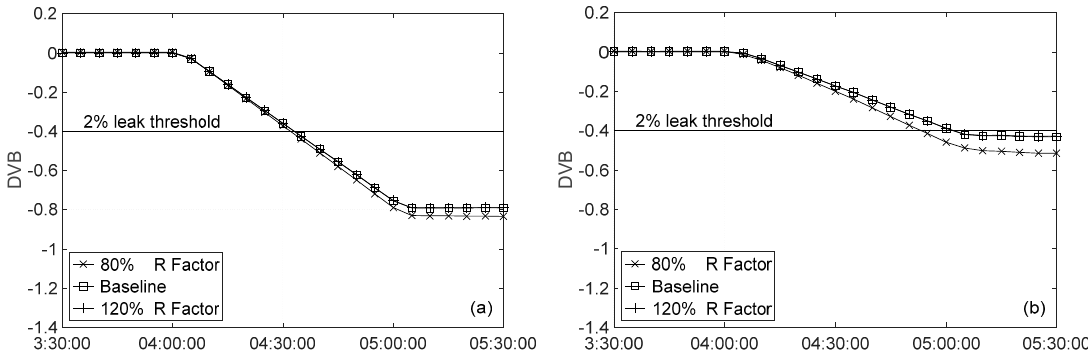
Figure 3. Effect of viscosity error on leak detectability in a system with R = 2.20 with 1% Gaussian noise: ( a ) flow decrease; and ( b ) flow increase.